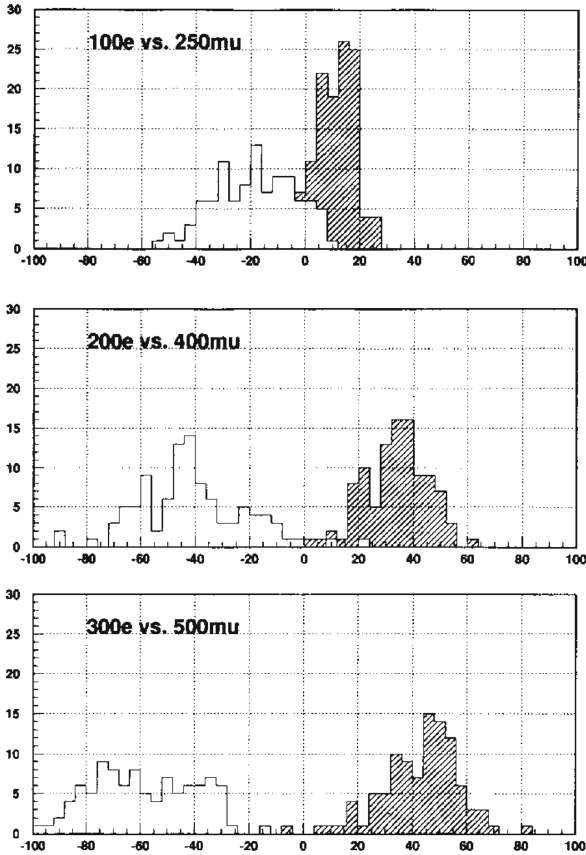
Fig. 4 The e-likelihood and μ -likelihood at similar total Cherenkov lights of (top) 100 MeV electron energy, (middle) 200 MeV, and (bot- tom) 300 MeV